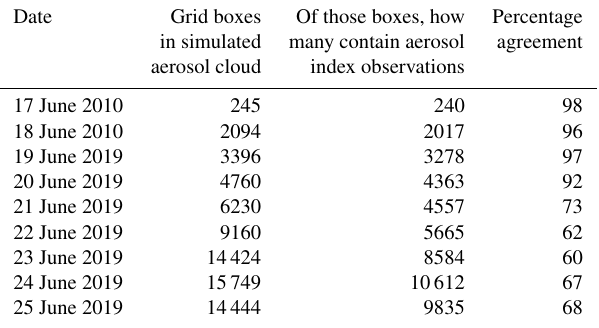
Table 4. Comparison between OMPS AI and NAME BBA simu- lation. Each simulated grid box is 0.2 ◦ latitude × 0.4 ◦ longitude at the surface – approximately 20km × 40km at